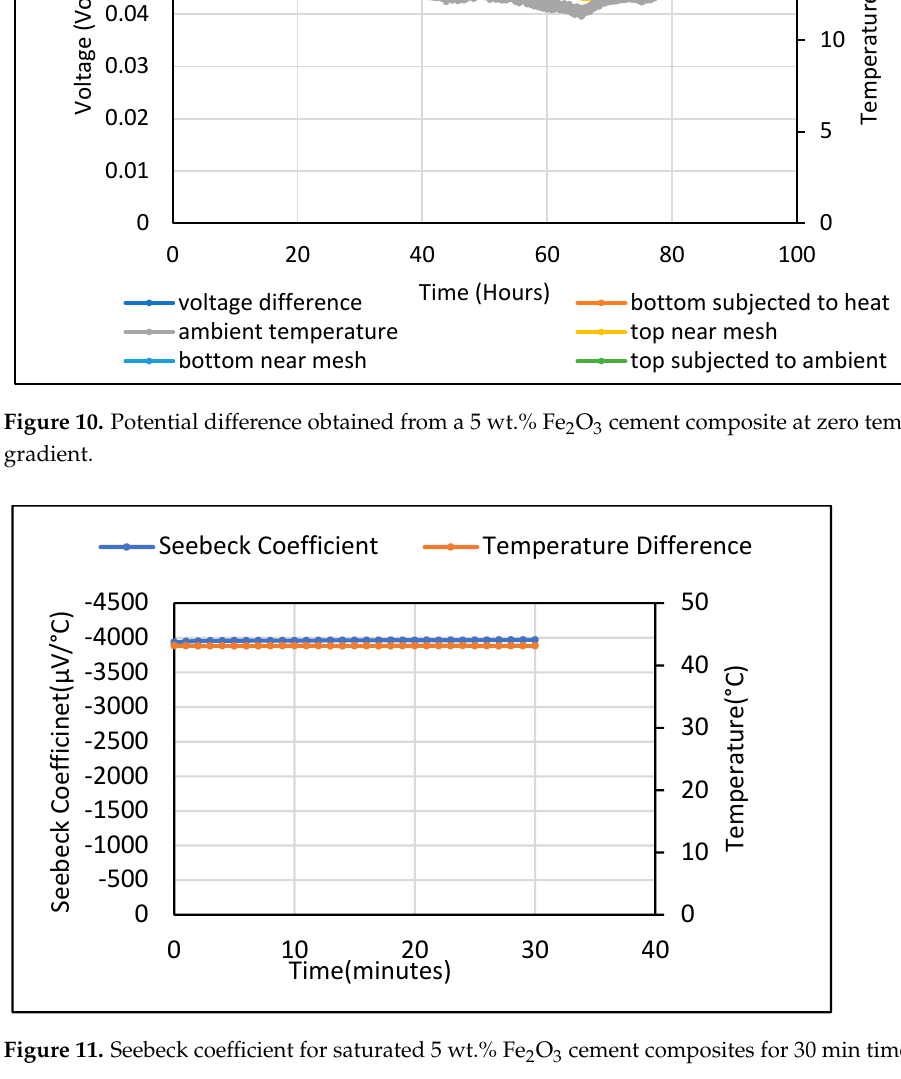
Figure 12. Seebeck coefficient at fixed temperature difference over 1-day time period for 5% Fe 2 O 3 cement composite.